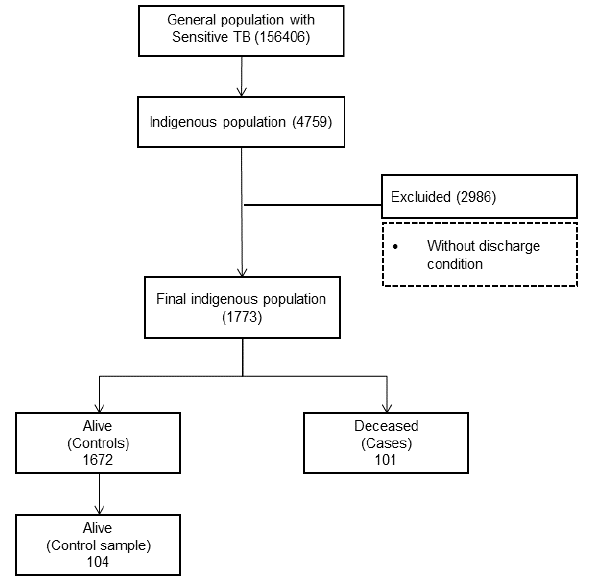
Figure 2. Flow chart of the study.